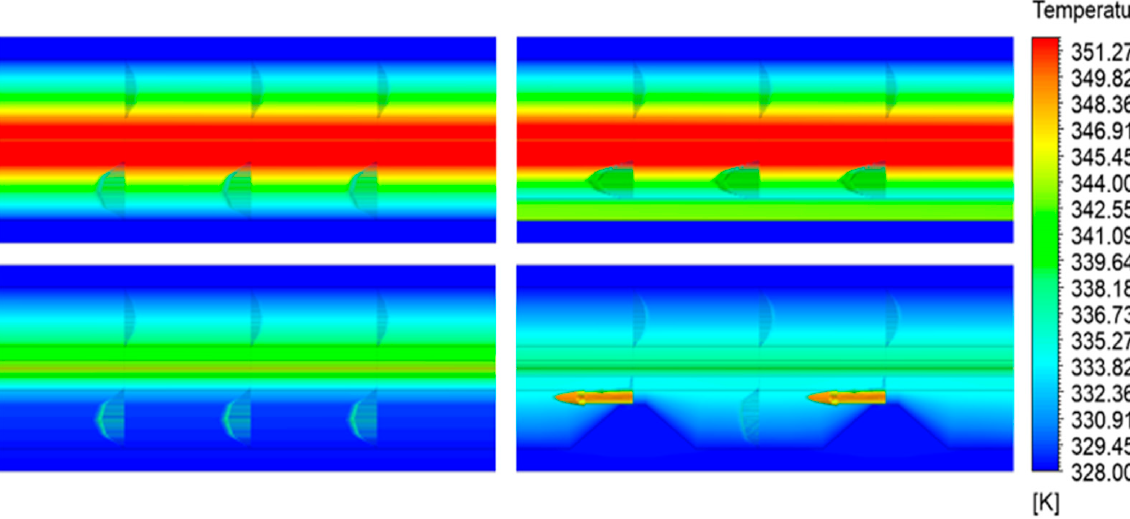
Figure 3. Temperature contours: conventional rectangular channels ( above left ); biporous cathode channel ( above right ); porous cathode channel ( below left ); porous and baffled cathode channel ( below right ) at operating current density of 4.0 A·cm − 2 .